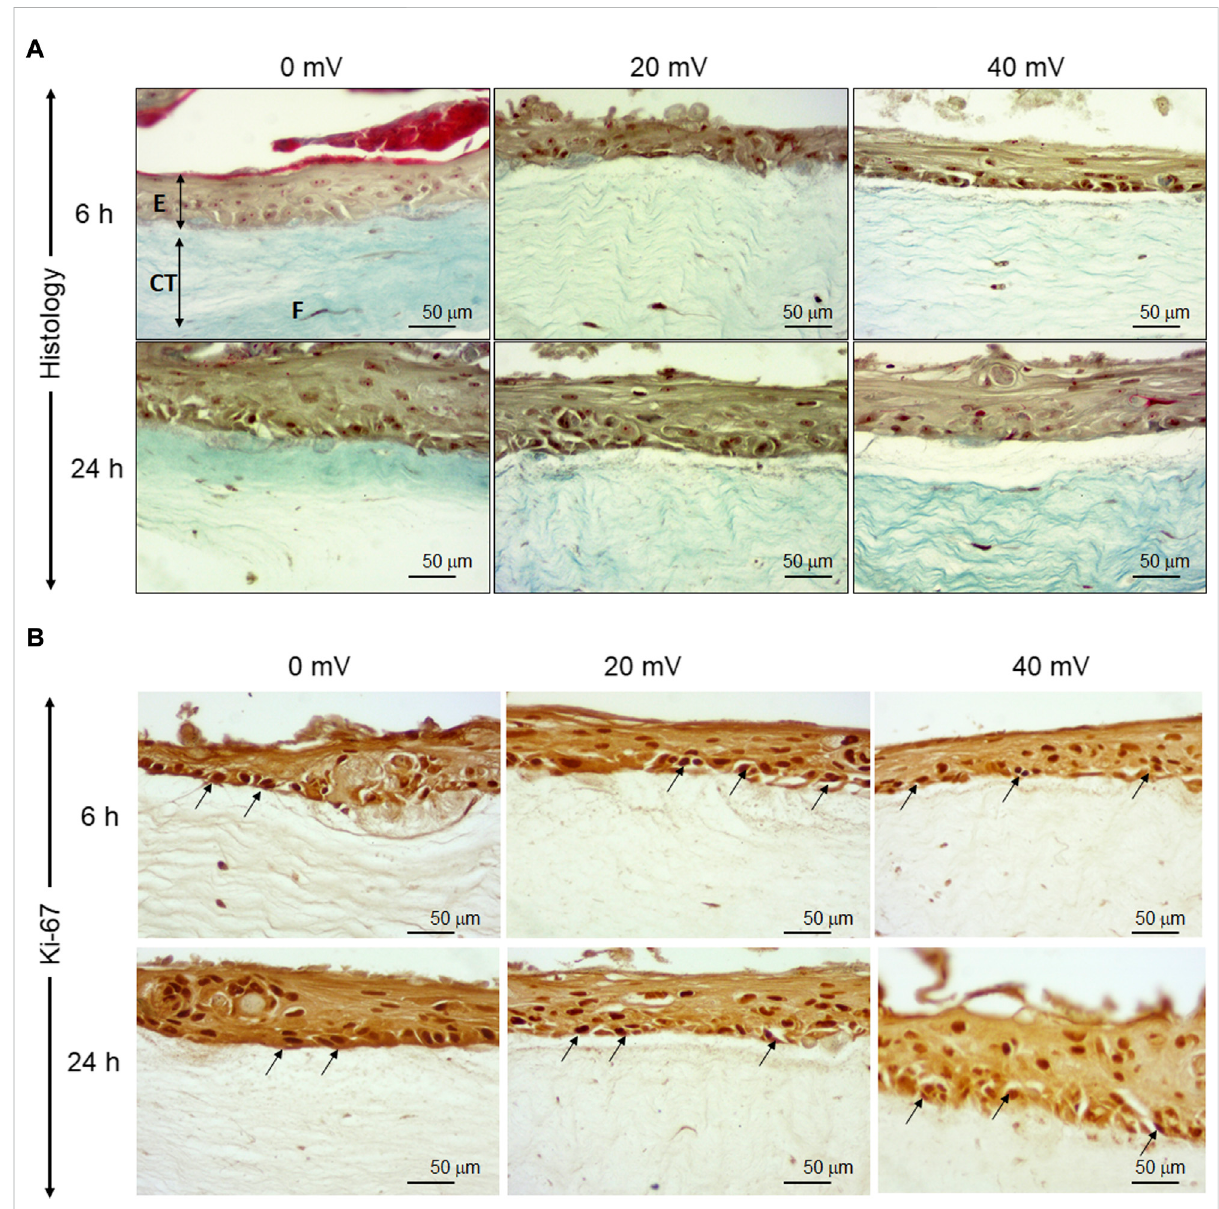
Tissue structureof diabetic skinequivalentafter exposure ornot to electrical stimulation. Skin equivalents weregenerated using fi broblastsand keratinocytes extracted from the skin of diabetic donors. The generated skin equivalents were exposed or not to electrical stimulation at 20 or 40 mV/mm. Immediately after exposure to ES, the tissues were subjected to structural analyses. Panel A shows Masson trichrome-stained tissues. Panel B shows Ki-67-stained cells. (E), epidermis; (CT), connective tissue; (F),